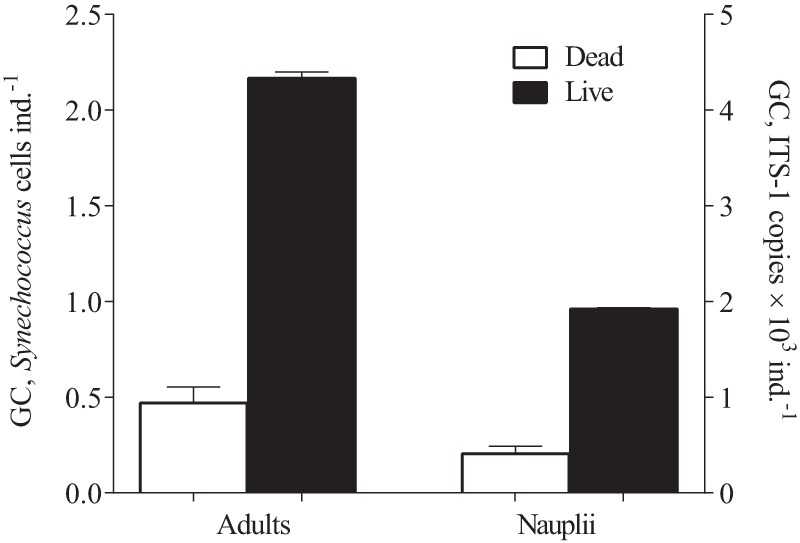
Quantities of Synechococcus bacillaris (ITS-1 copies ×103 ind−1and cells ×103 ind−1) detected in the live and dead individuals of the copepod Acartia tonsa (adults and nauplii) exposed to the picocyanobacterium in the feeding experiments (Experiments I and II).Data are shown as mean ± SD, n = 3 in all cases.